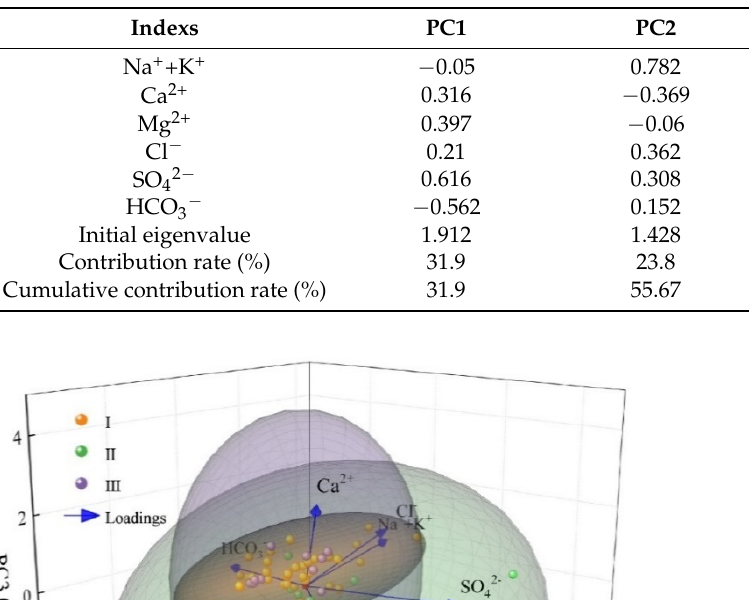
Table 4. Principal component analysis results of conventional components of karst groundwater in Taiyuan Formation.